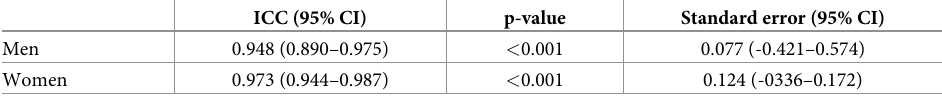
Table 5. Intraclass correlation coefficient and standard error of estimated appendicular skeletal muscle mass in the cross-validation